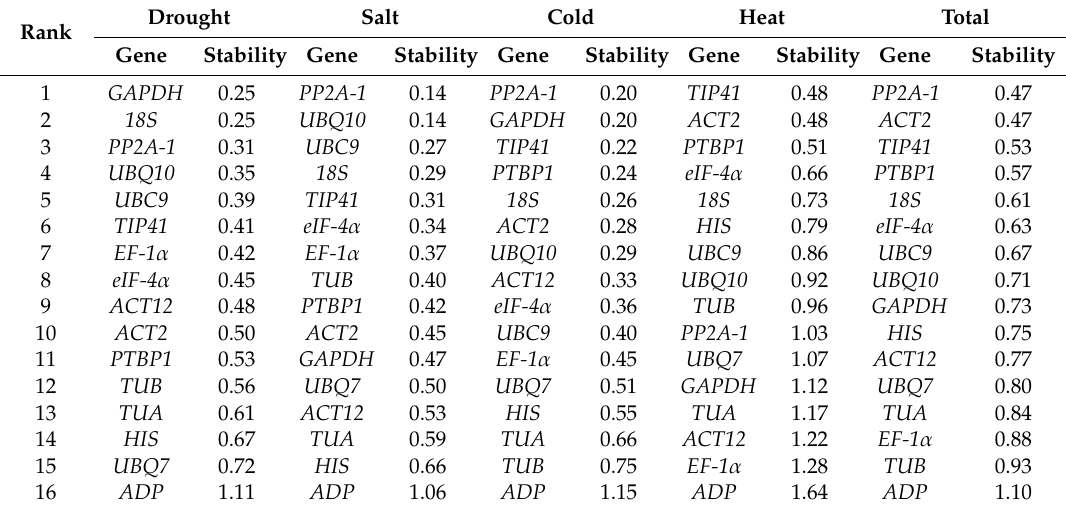
Table 3. Expression stability of candidate reference genes calculated by